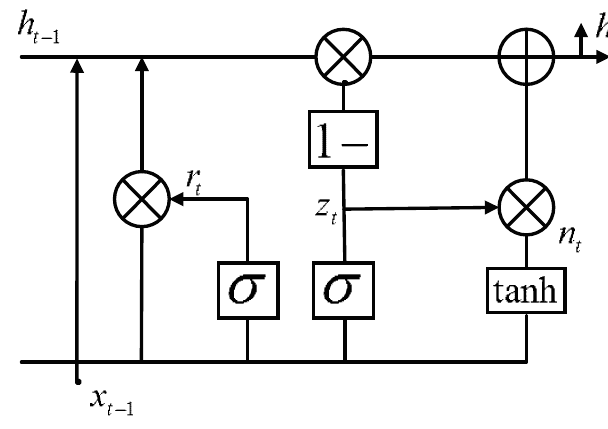
Figure 1. Structure of GRU